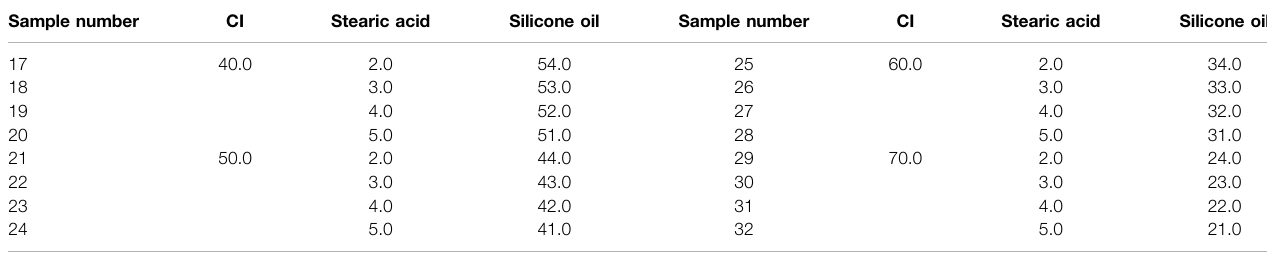
TABLE 2 | The constituent of MRF with stearic acid.